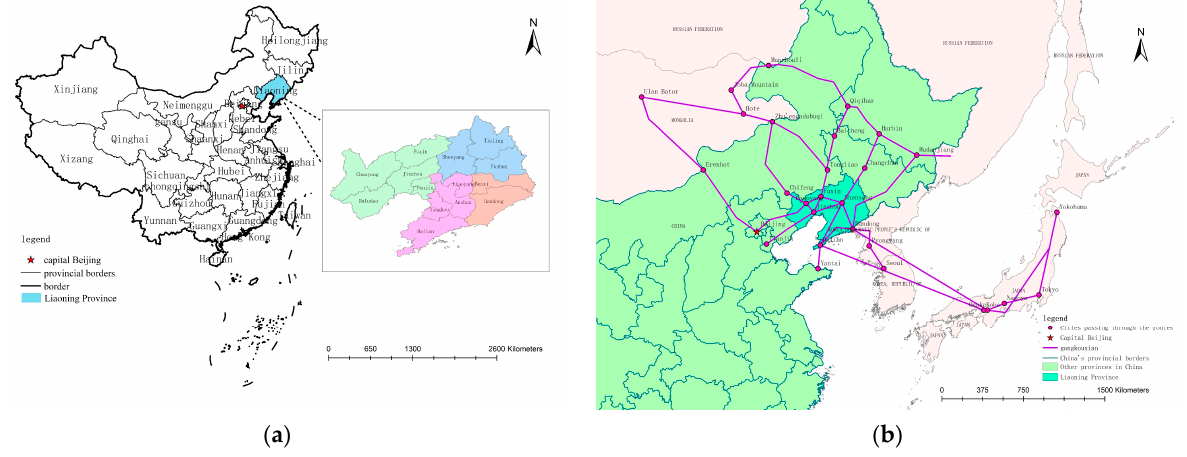
Figure 1. ( a ) Position of Liaoning Province in China. ( b ) Main external routes of ports in Liaoning Province.